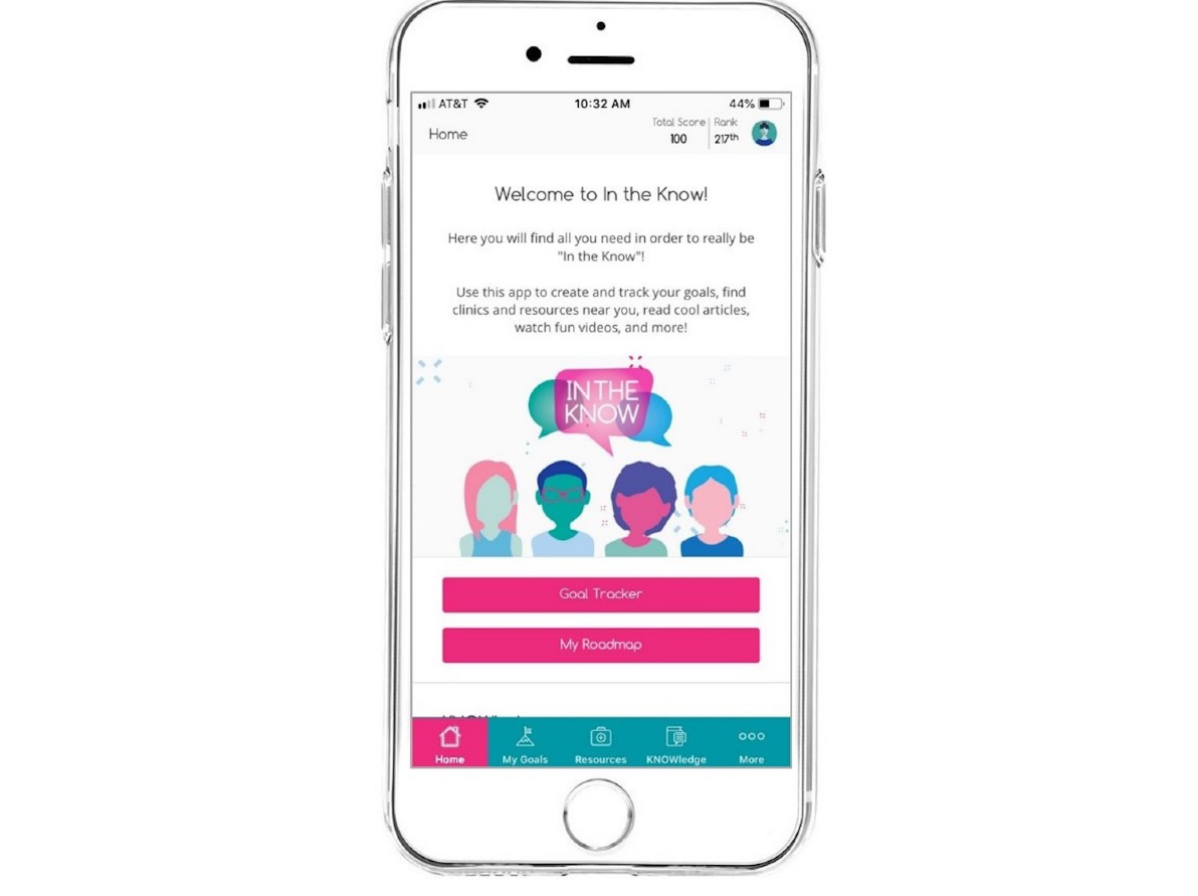
Figure 1. Sample screenshot from mobile